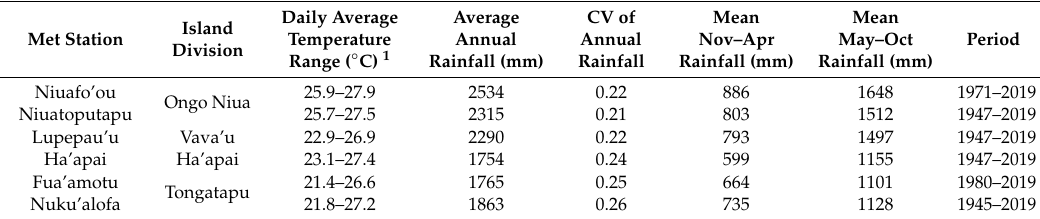
Table 4. Annual, wet (November to April) and dry season (May to October) rainfall characteristics at meteorology stations in Tonga